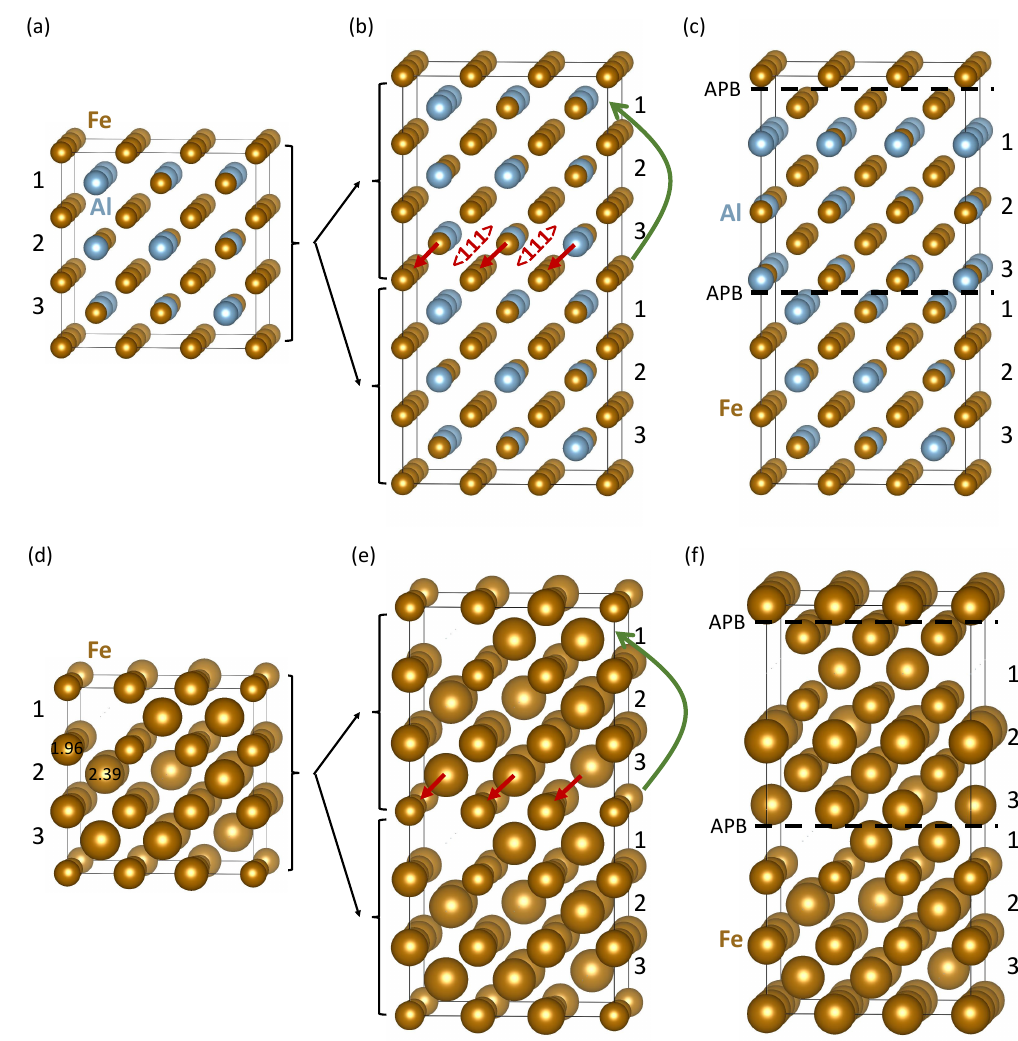
Figure 1. Schematic visualizations of our way of constructing sharp antiphase boundaries (APBs) in Fe 70 Al 30 alloy. A 54-atom supercell in part ( a ) is a 3 × 3 × 3 multiple of 2-atom body-centered cubic (bcc) elementary cell and it is our model of the B2 phase of Fe 70 Al 30 . It consists of atomic planes (i) containing only Fe atoms which are separated by planes (ii) containing both Fe and Al atoms (the latter with the atoms distributed according to the special quasi-random structure (SQS) concept). As each Fe-Al plane is different, they are numbered 1–3. Two of these 54-atom cells stacked along the [001] direction form a supercell ( b ) which was used for constructing the studied APBs. In particular, when applying a (cid:104) 111 (cid:105) shift to all atoms in the upper half of the supercell ( b ), a supercell ( c ) with two sharp APBs (see dashed lines) is formed. The (cid:104) 111 (cid:105) shift is indicated by the red vectors in part ( b ). In order to apply the (cid:104) 111 (cid:105) shift to all atoms in the upper half of ( b ), one Fe atomic plane is cyclically shifted as schematically visualized by a curved green arrow. The computed local magnetic moments of atoms in supercells ( a – c ) are shown in parts ( d – f ), respectively. The magnitude of local magnetic moments are visualized by the diameter of spheres representing atoms—two values in Bohr magnetons µ B are given in ( d ) in order to show the